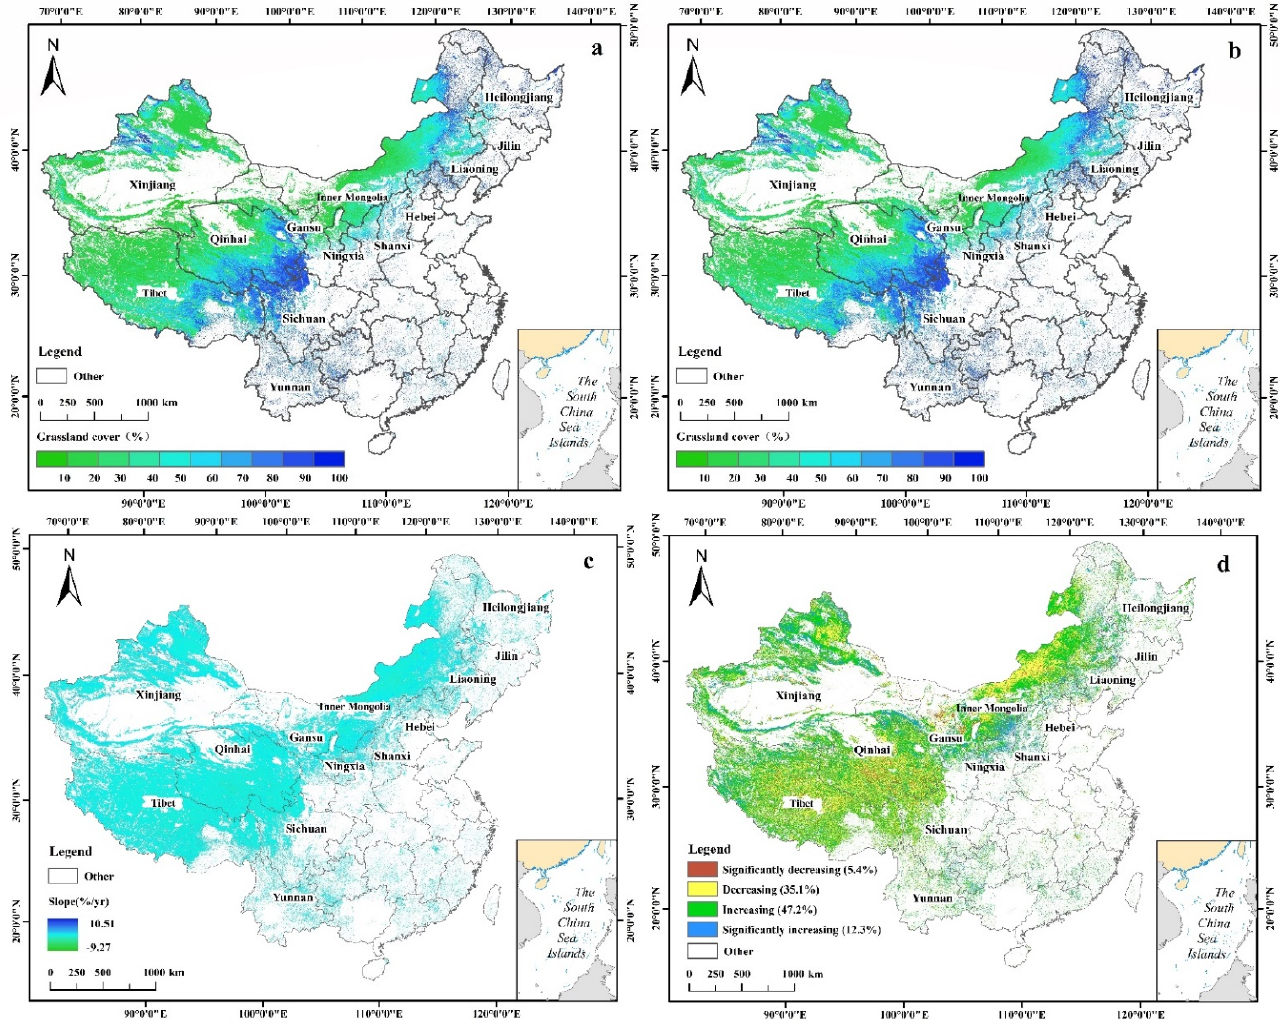
Figure 3. The spatial distribution and trends of grassland coverage in China before (2004–2010) and after (2011–2017) the implementation of the SISGC. The average coverage before the SISGC imple- mentation ( a ); the average coverage after the SISGC implementation ( b ); ( c ) trend change (2004– 2017); trend change grading ( d